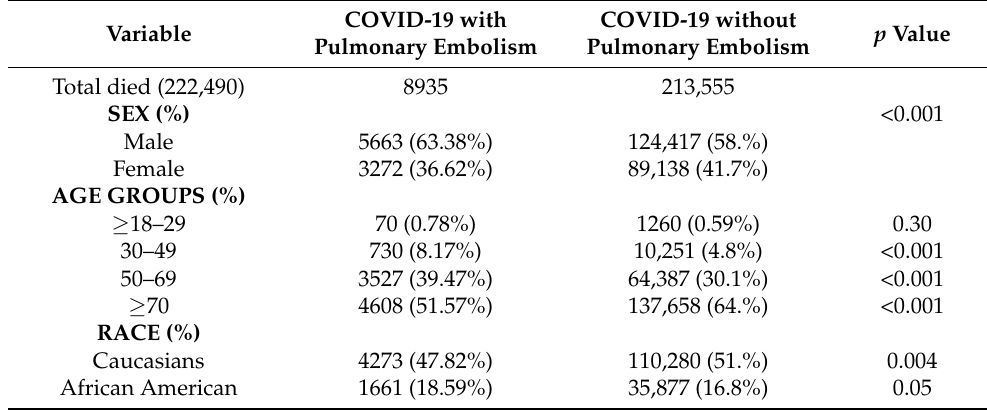
Table 4. Mortality breakdown Patients with COVID-19 with and without pulmonary embolism (unmatched